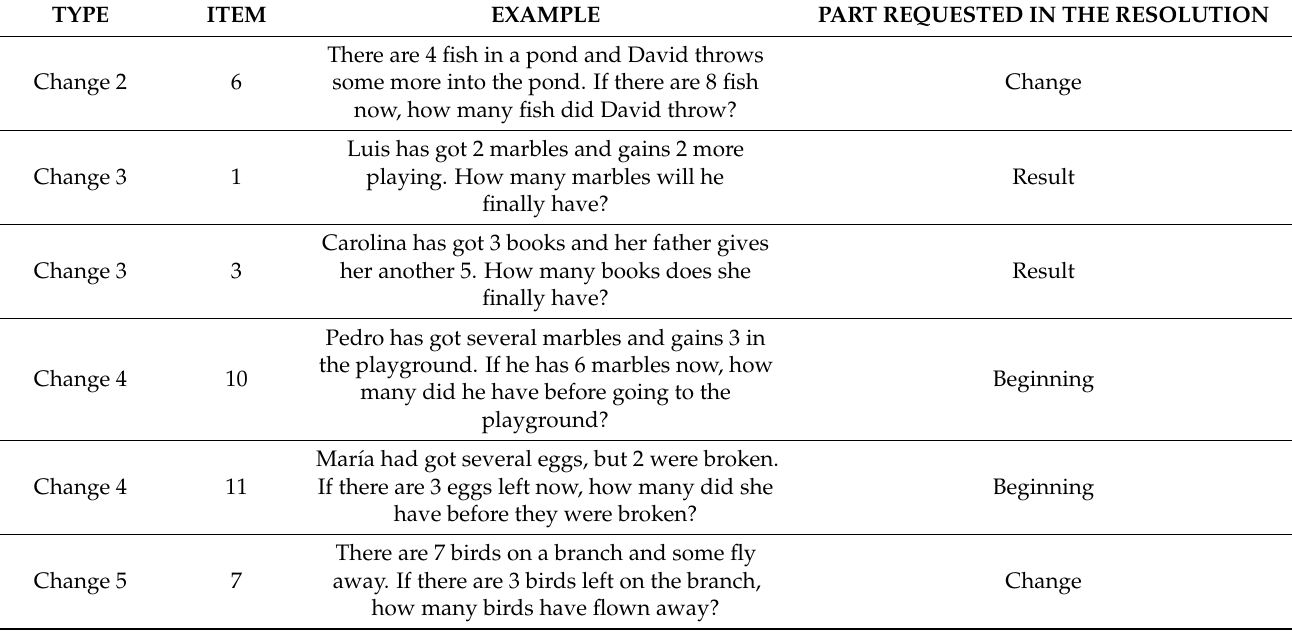
Table 2. Classification of